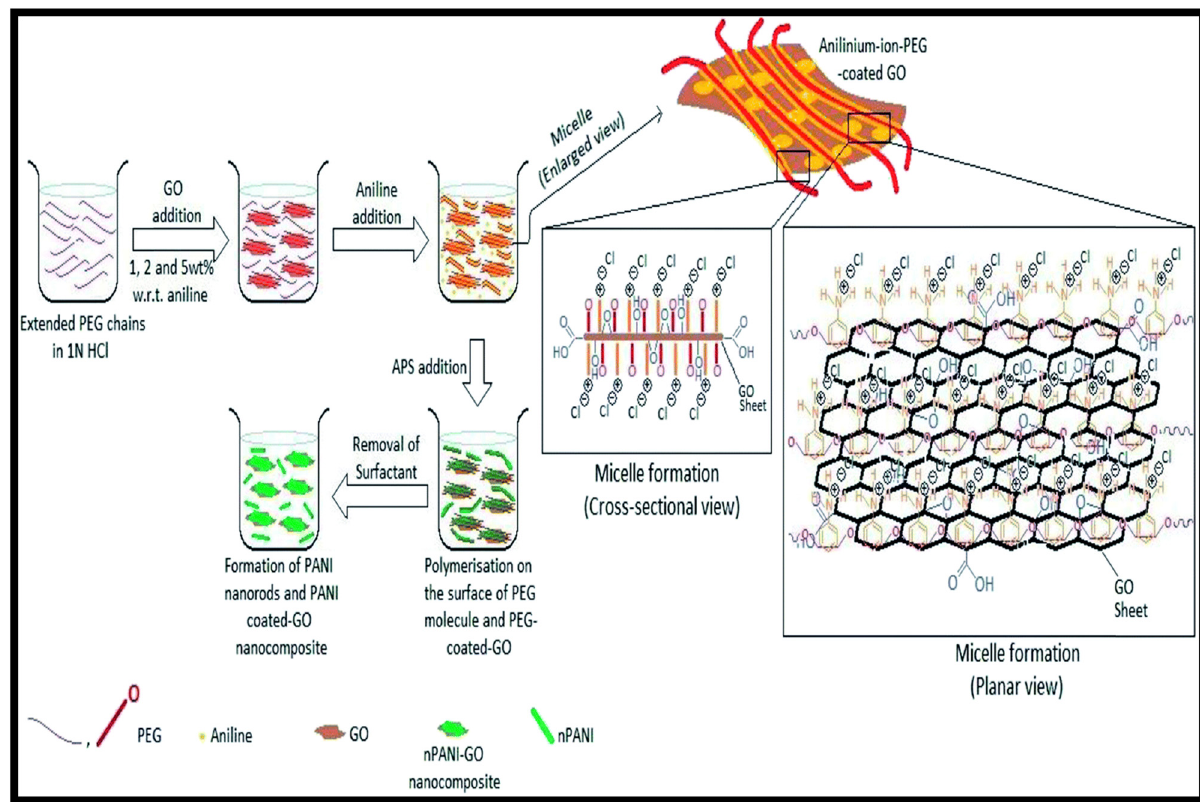
Figure 26: Various steps are involved in the preparation of n - PANI – GO composites along with the representation of both cross - sectional and planar views of the intermediate structures [ 176 ]